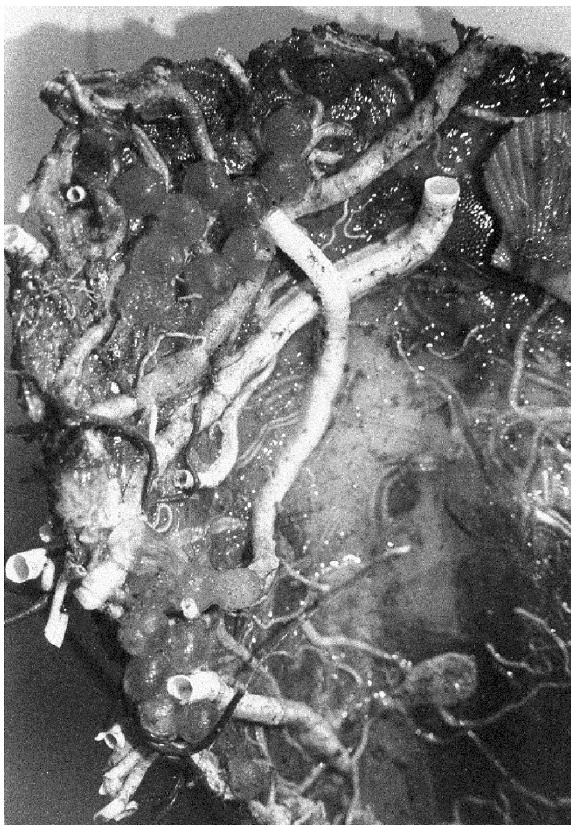
F IG . 3. – An empty pen shell, Atrina pectinata , with a 10 egg clutch of Sepietta oweniana (top left) and a 7 egg clutch plus an empty egg case of Sepiola sp. (bottom left), collected in the Catalan Sea.